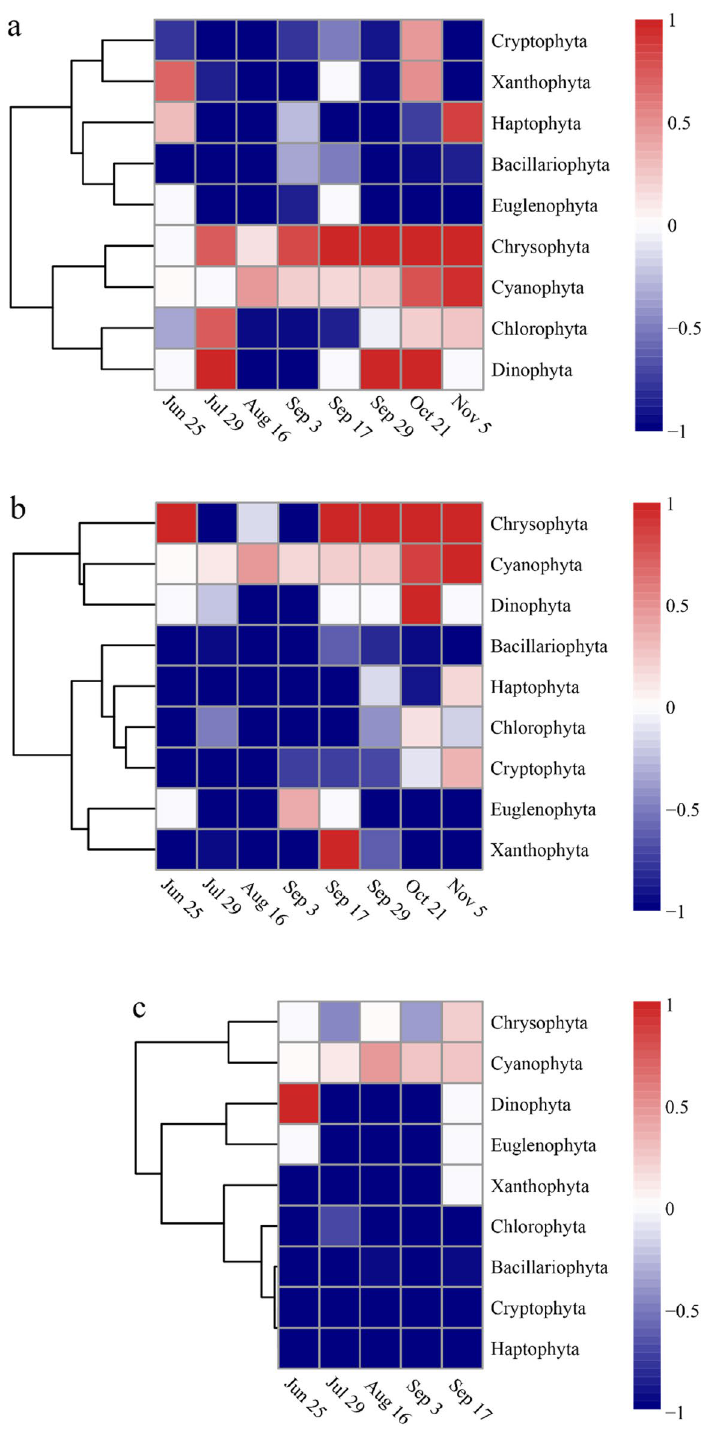
Figure 7. Heatmaps showing feeding selectivity of M. mercenaria ( a ), M. meretrix ( b ) and R. philippinarum ( c ) on phytoplankton at the phylum